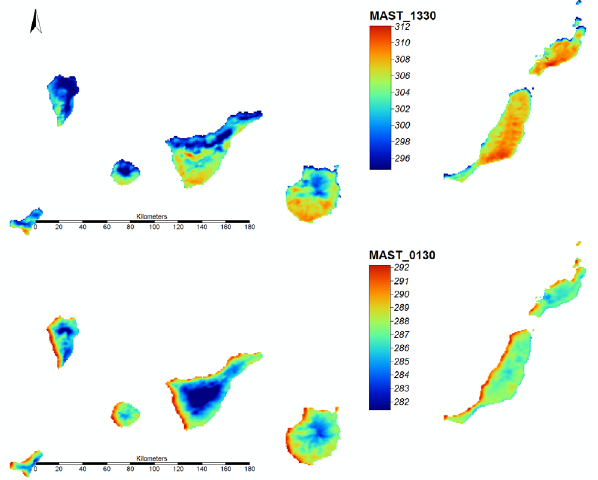
Figure 6. Yearly amplitude of surface temperature (YAST) in K at 1:30 (upper) and 13:30 (lower) overpass